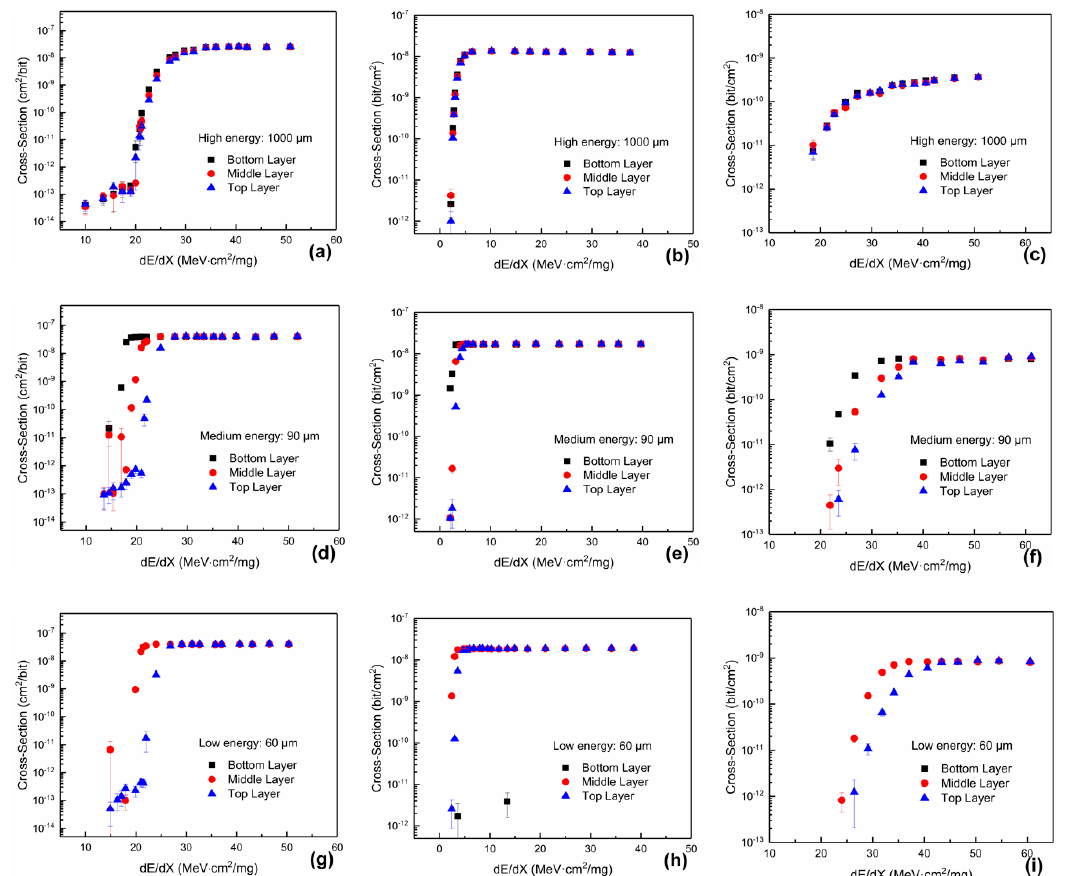
Figure 3. Each tier’s CS of ( a , d , g ) the bulk silicon SRAM, ( b , e , h ) the 6T partially depleted SOI (PDSOI) SRAM, and ( c , f , i ) the ADE PDSOI SRAM as a function of LET under different heavy-ion energies.